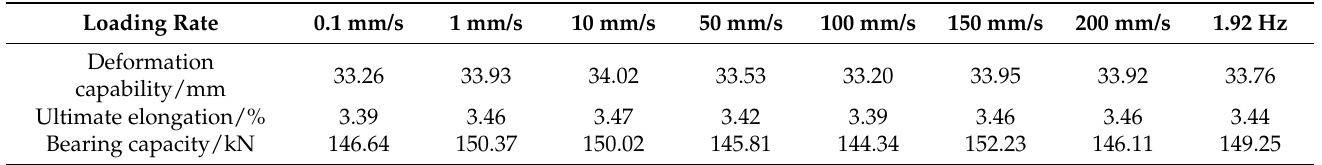
Figure 9. Hysteretic performance of the BFRP tendons under different loading rates: ( a ) 0.1 mm/s; ( b ) 1.0 mm/s; ( c ) 10 mm/s; ( d ) 50 mm/s; ( e ) 100 mm/s; ( f ) 150 mm/s; ( g ) 200 mm/s; ( h ) 1.92 Hz. Table 3. Summary of the hysteretic behaviors of the BFRP